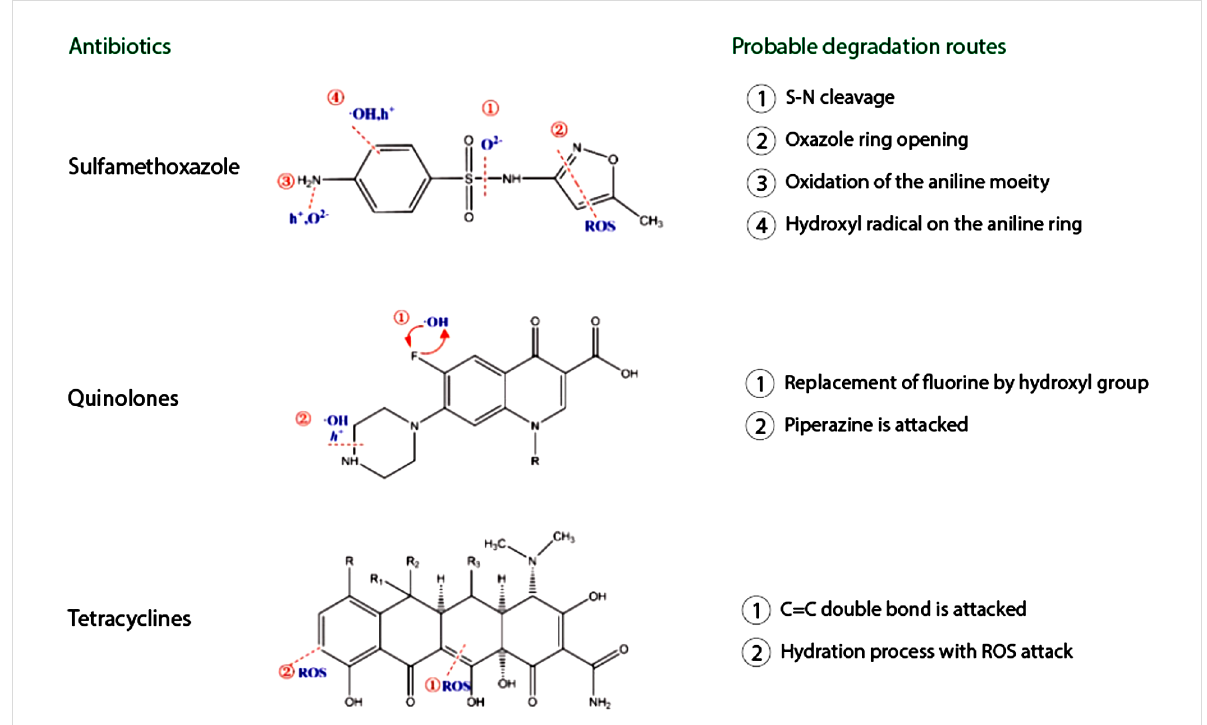
Figure 5: Photocatalytic degradation pathways of antibiotics by bismuth-based photocatalyst. (Adapted from [191], Environmental Research, Vol. 199, by K. Qin; Q. Zhao; H. Yu; X. Xia, J. Li; S. He; L. Wei; T. An, “A review of bismuth-based photocatalysts for antibiotic degradation: Insight into the pho- tocatalytic degradation performance, pathways and relevant mechanisms “, Article No. 111360, Copyright (2021), with permission from Elsevier. This content is not subject to CC BY 4.0.)